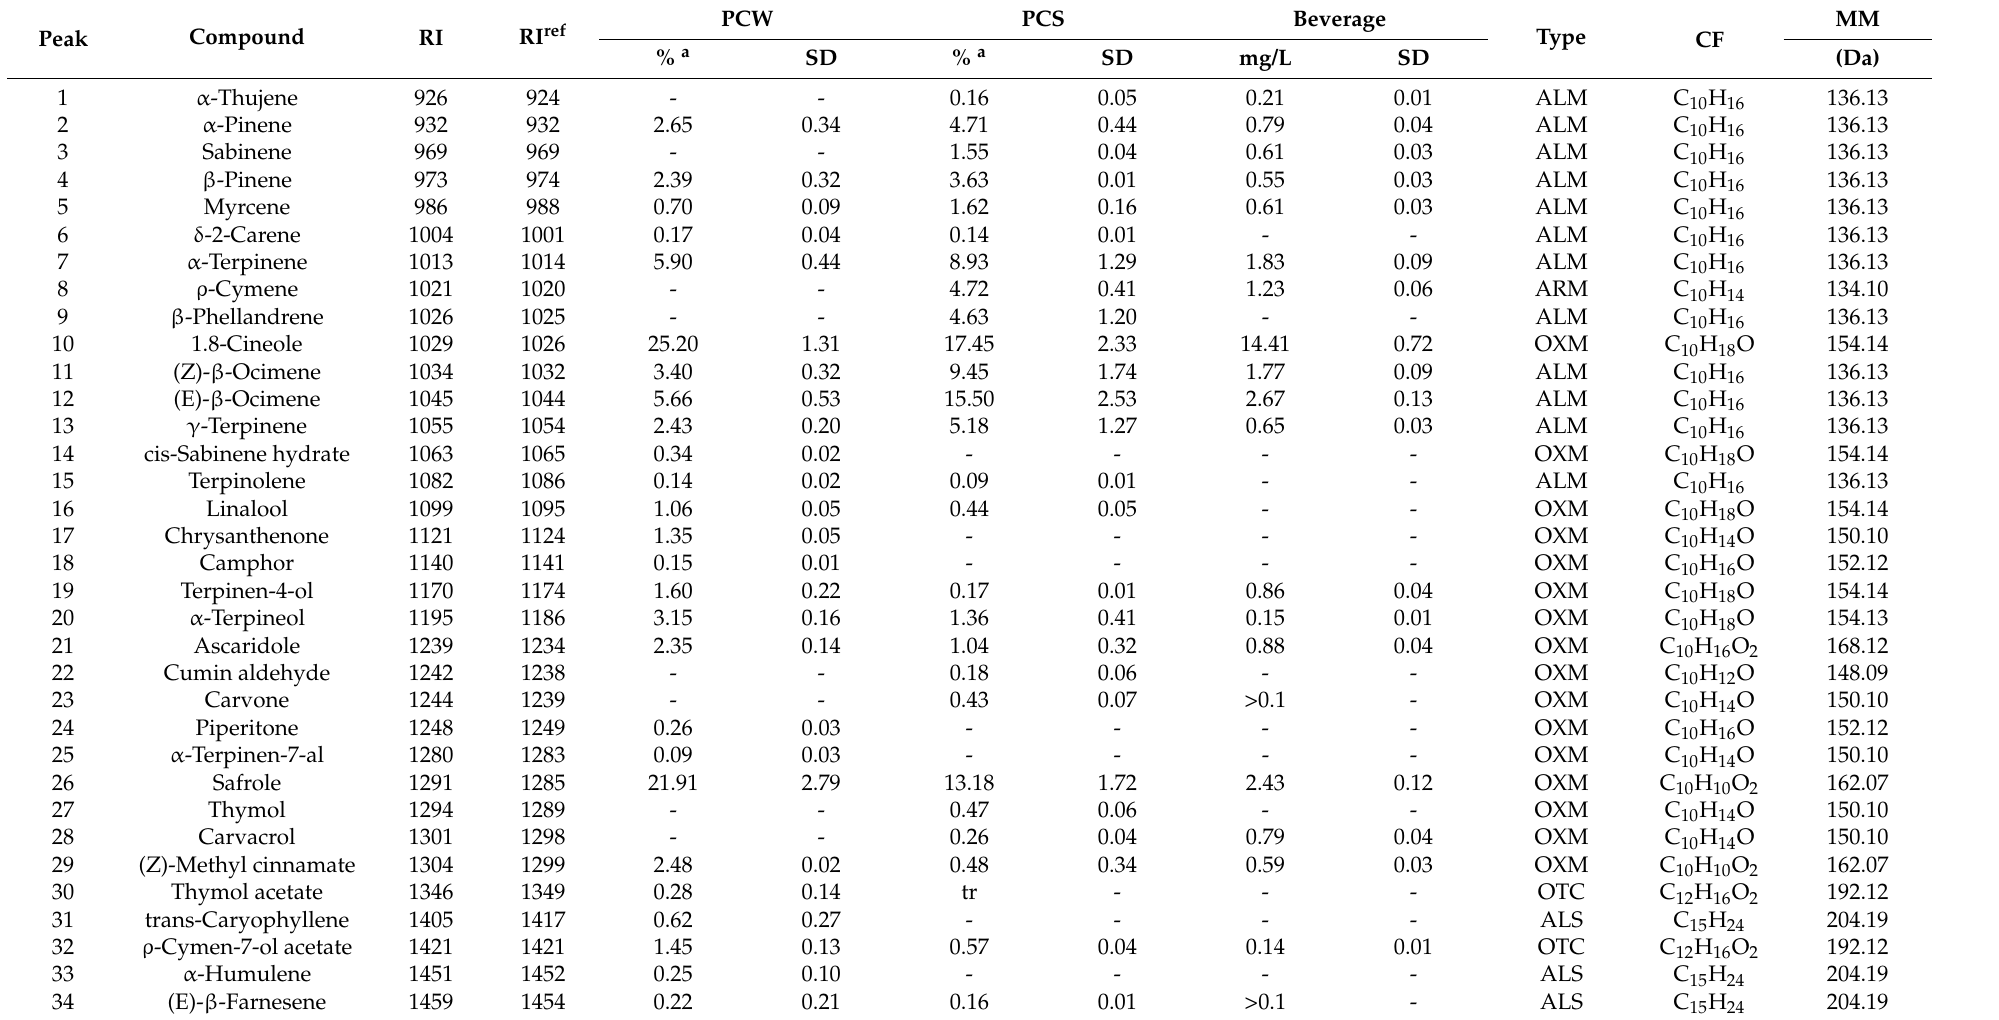
Table 1. Chemical composition of volatile compounds from Piper carpunya leaves collected in winter (PCW) and summer (PCS) and from the guaviduca beverage.